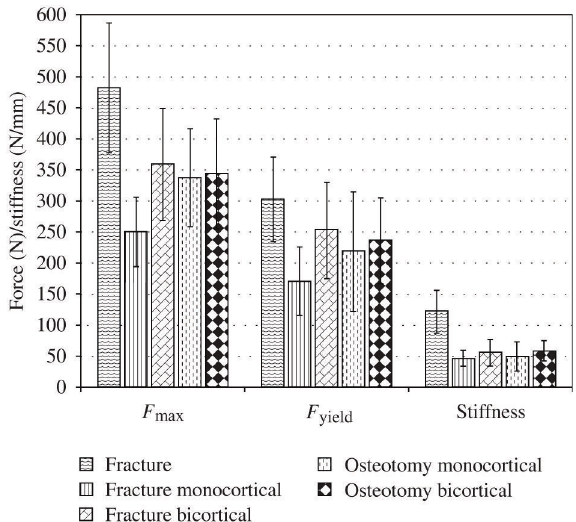
FIGURE 3: Maximum load (N), yield load (N), and stiffness (N/mm) of native bones, osteotomy and fracture model.